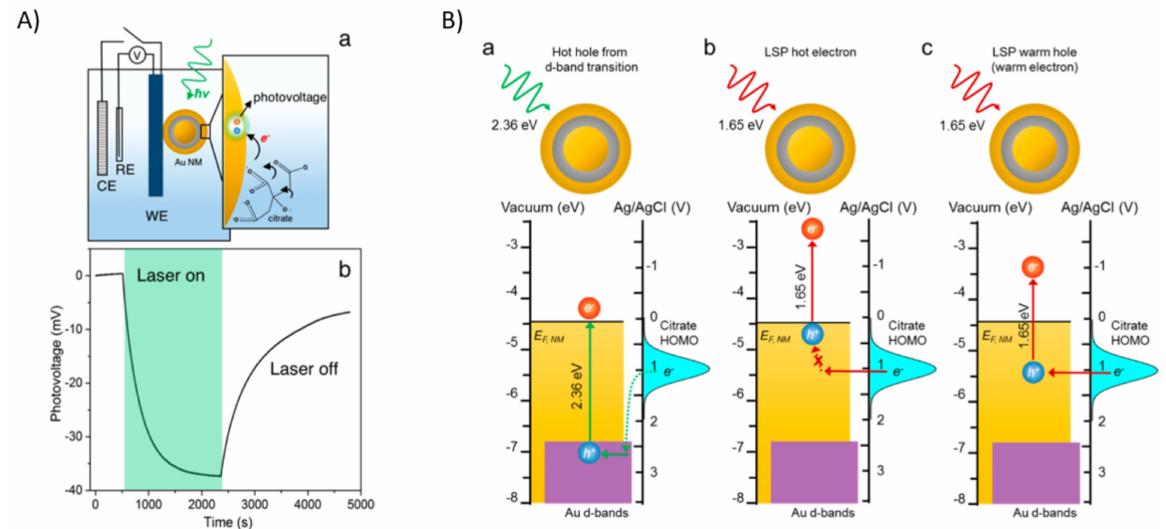
Figure 8. ( A ) a Scheme for the citrate oxidation under 2.36 eV of laser irradiation, and ( A ) b Open Circuit Potential measurements. Adapted with permission from Schlather et al. J. Phys. Chem. Lett. 2017, 8, 9, 2060–2067 Copyright 2017, American Chemical Society [25]. ( B ) a Scheme for the oxidation of the citrate employing the hot-electrons using the BD mode. ( B ) b Scheme where cannot be achieved the citrate oxidation in the ABD mode with warm-electrons, and ( B ) c Citrate oxidation using the ABD mode. Adapted with permission from Schlather et al. J. Phys. Chem. Lett. 2017, 8, 9, 2060–2067 Copyright 2017, American Chemical Society